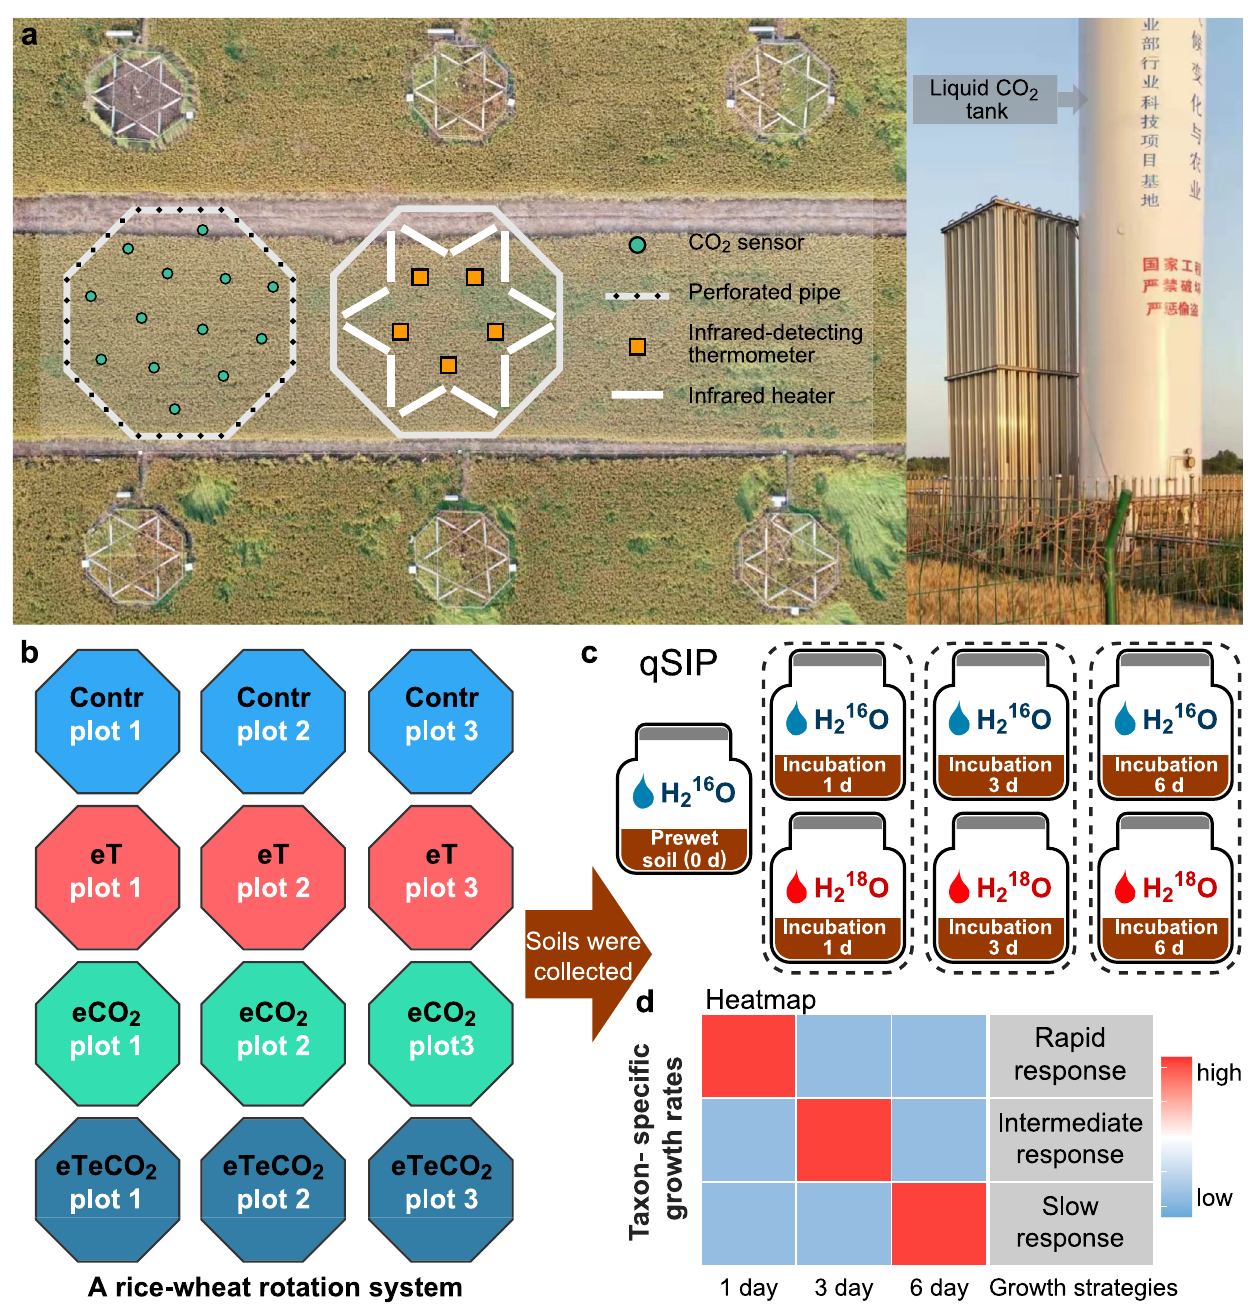
Fig. 1 | Field and laboratory experimentaldesign. Toexaminetheeffects of CO 2 enrichment (500 ppm CO 2 ) and warming (+2°C) for a typical rice-wheat rotation system, an open-air experimental fi eld was started in 2010 ( a ). Four treatments with twelve 50 m 2 rings (each treatment with three biological replicates) were set ( b ). A qSIP incubation experiment was performed to determine the growth stra- tegiesofactivemicrobesineachclimatechangetreatment( c ).Brie fl y,2gair-dried soils with 400 μ L of natural abundance water (H 2 16 O) or 98 atom% H 2 18 O were